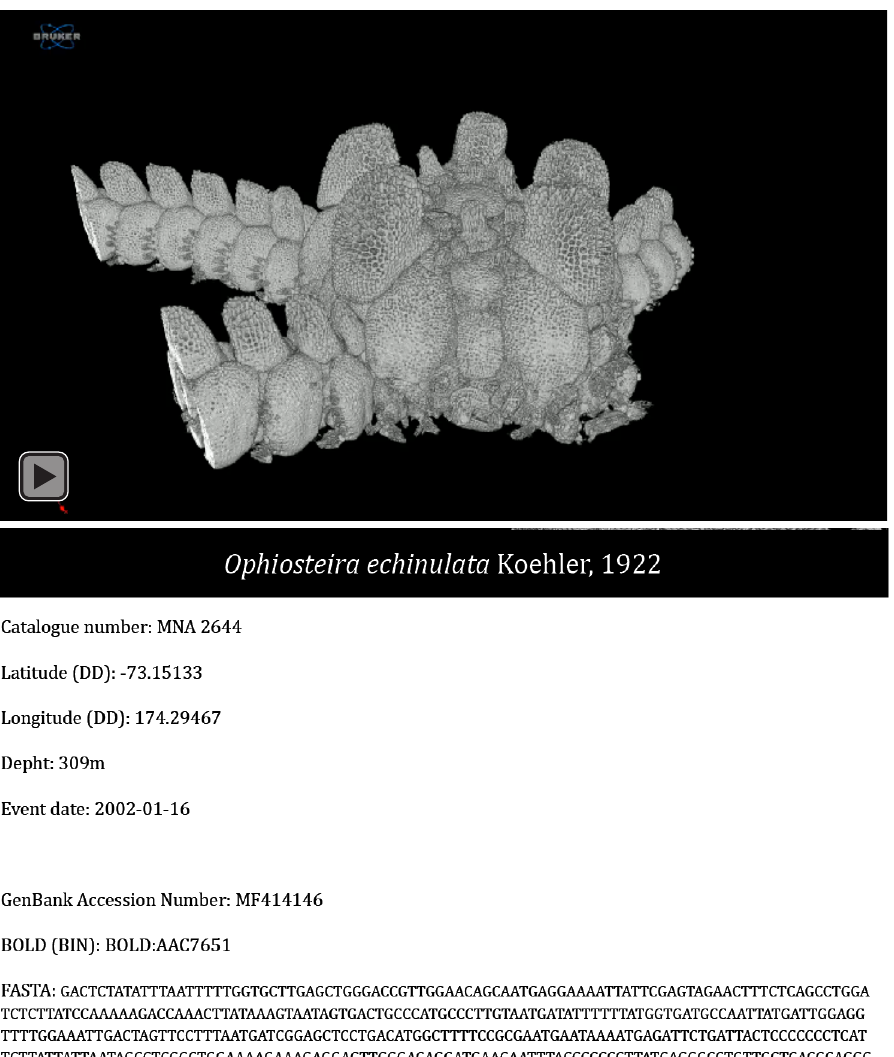
Figure 7. Video of the 3D model of O. echinulata (MNA 2644); Catalogue number, latitude (DD), lon- gitude (DD), depth and event date as described in the section “Dataset description”, GenBank Accession number, Barcode Index Number from the Bold system and the complete COI sequence in FASTA